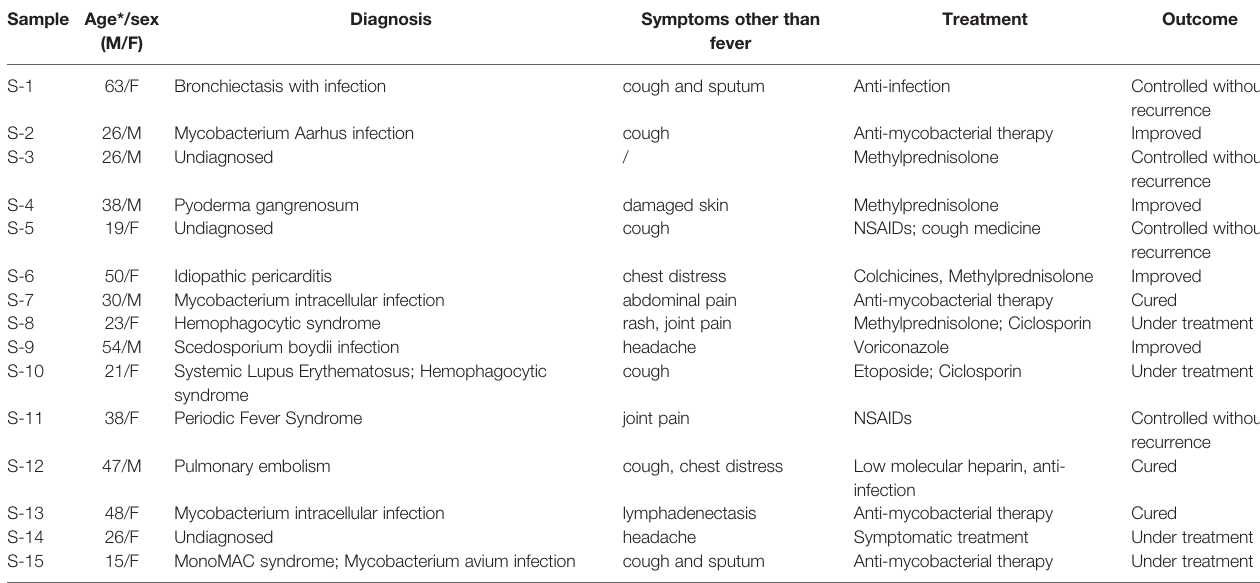
TABLE 1 | Clinical characteristics of